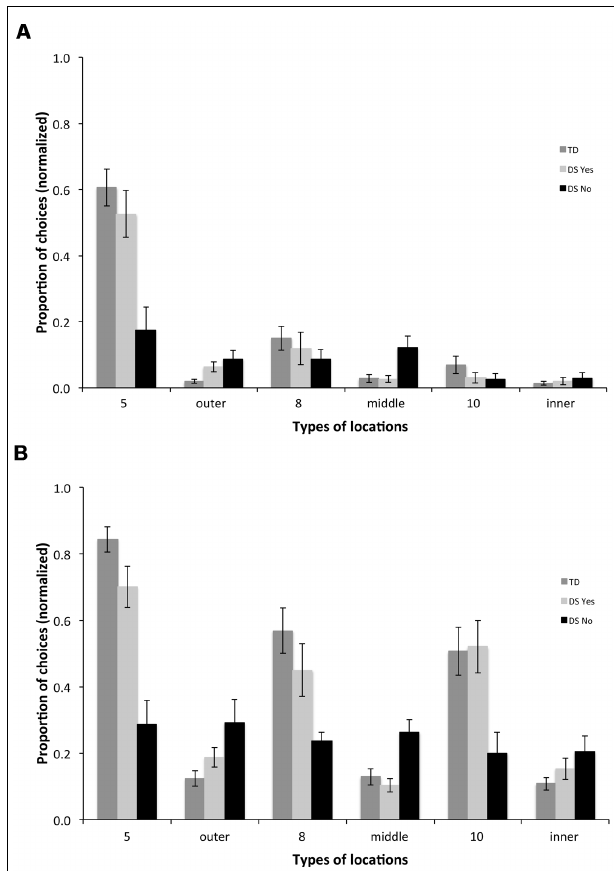
FIGURE 7 |Types of locations visited for the first (A) and the first three (B) choices upon entering the arena in theAS condition. 5: rewarded location on the outer array; outer: non-rewarded locations on the outer array; 8: rewarded location on the middle array; middle: non-rewarded locations on the middle array; 10: rewarded location on the inner array; inner: non-rewarded locations on the inner array.